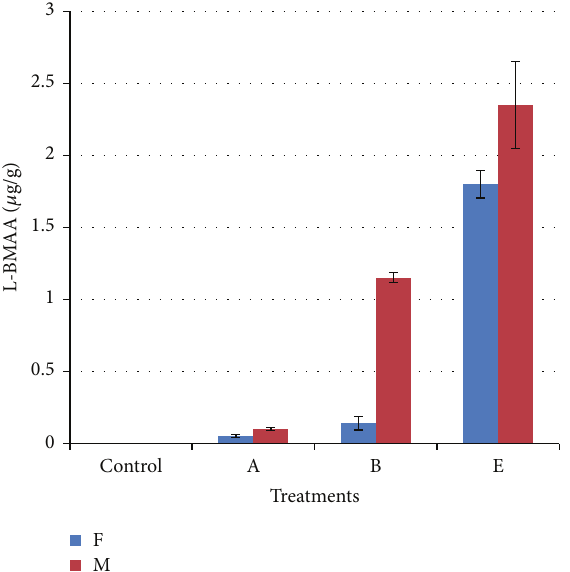
Figure 4: Comparison of L-BMAA concentrations ( 𝜇 g/g) in livers of male and female mice as detected by UPLC-UV. T-bars represent the mean of 𝑛 (𝑛 = 3 ) ± SD. A, B, and E: mice treated (0.03, 0.3, and 3mg/g BW) groups.